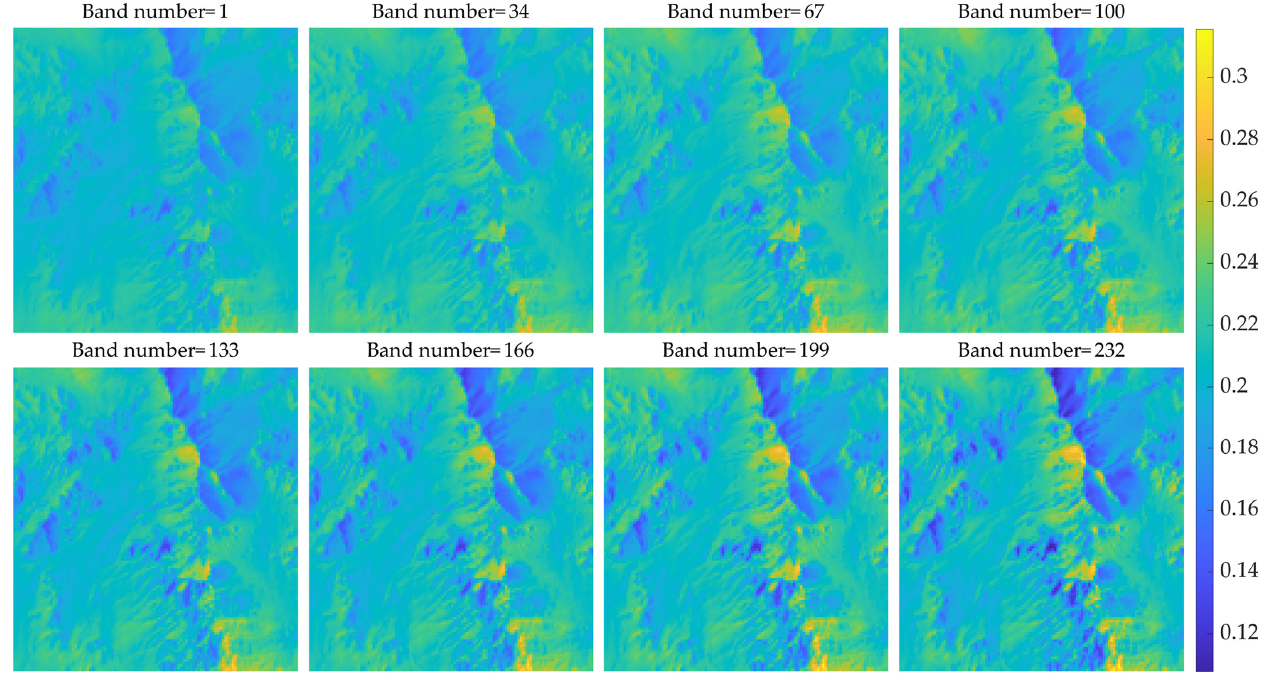
Figure A1. Comparison of 8 bands of frt00004af7_07_if164l_trr3 low-resolution data.